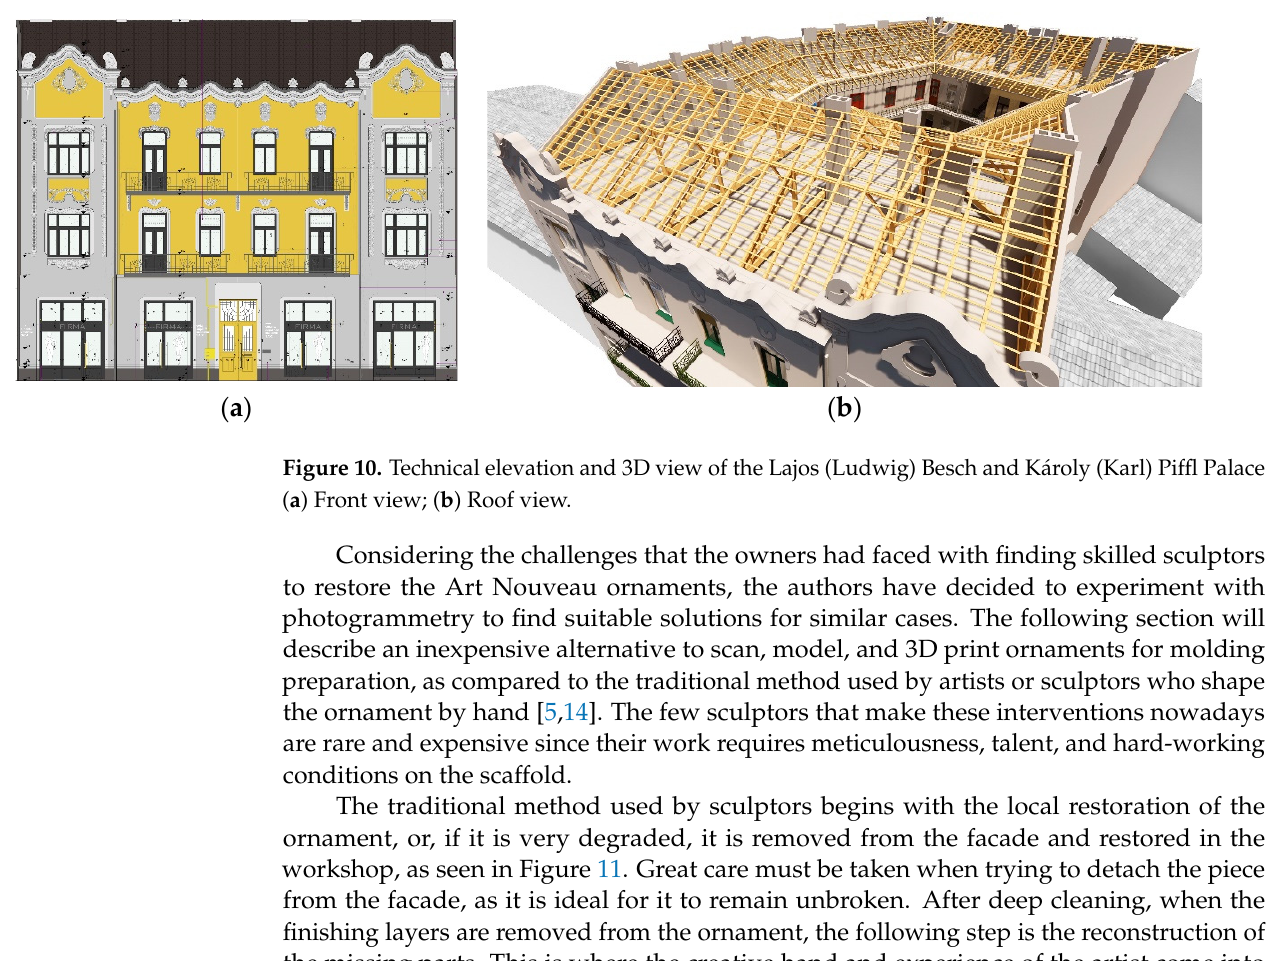
Figure 9. Art Nouveau/Secession motifs—Lajos (Ludwig) Besch and Károly (Karl) Piffl Palace [13] ( a ) General view; ( b ) First floor window; ( c ) Lateral roof detail; ( d ) Central roof detail.